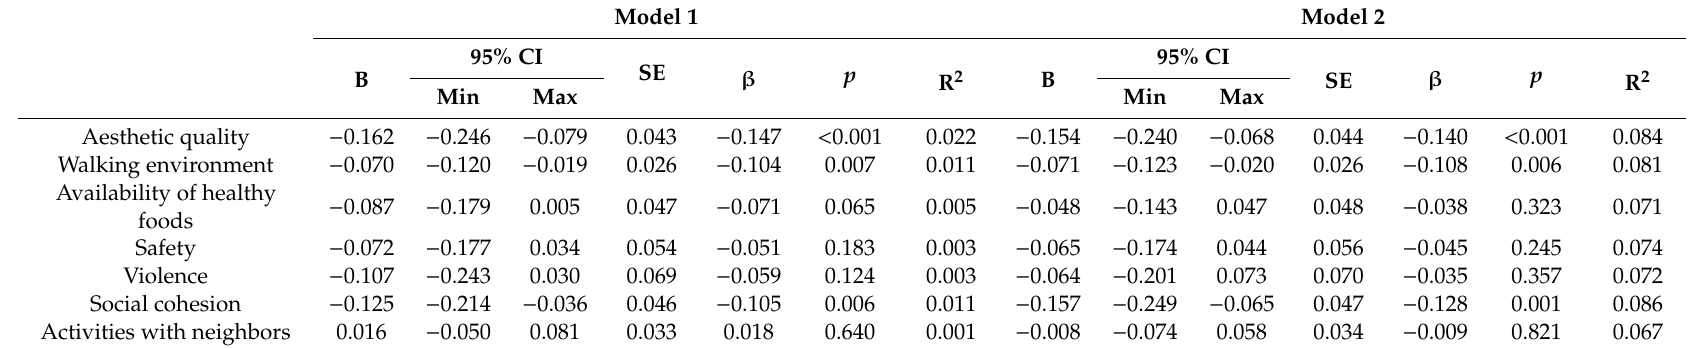
Table 3. Association between neighborhood characteristics and externalizing